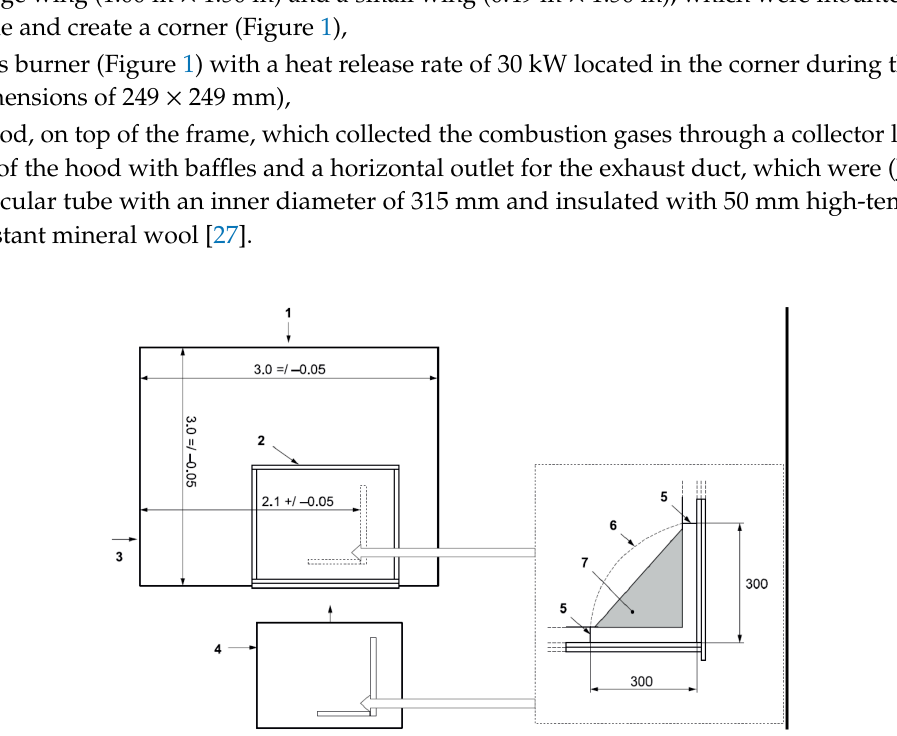
Figure 1. Scheme of single burning item (SBI) set up based on EN 13,823 [27]. Left side: 1,3—visual observations, 2—fixed frame, 4—trolley; right side: 5—boards covering the edges, 6—borders of the burner heating zone, 7—ignition source (burner).